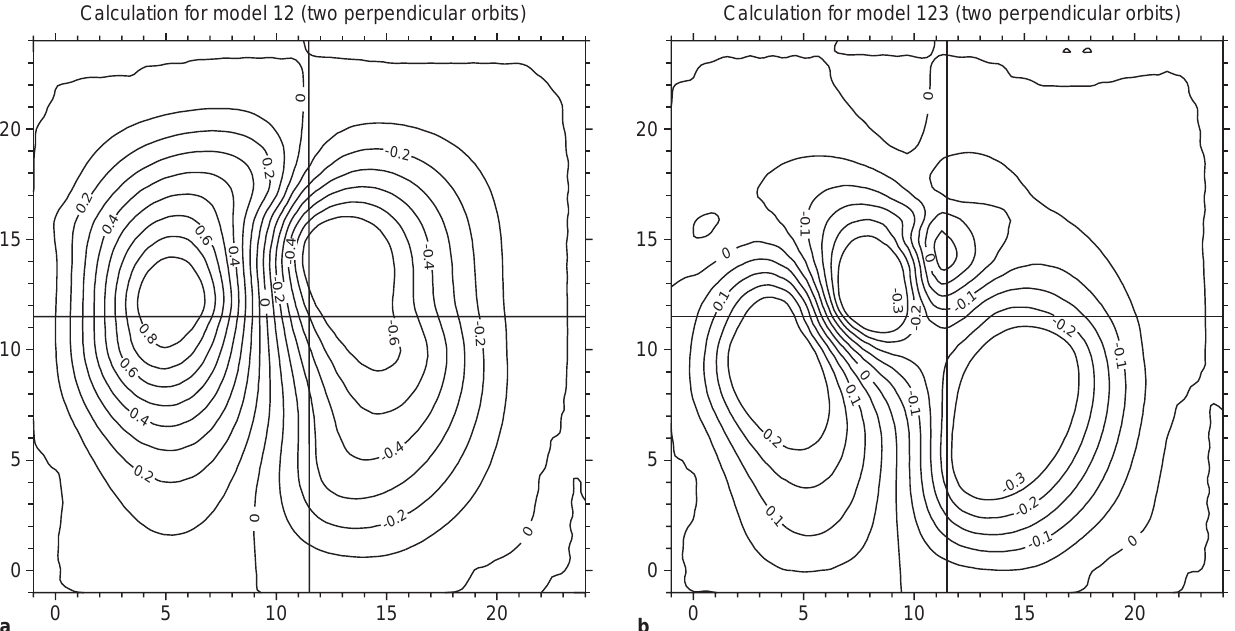
Fig. 5a, b. Convection patterns reconstructed by using the data along two perpendicular lines (one orbit case). a 2-cell convection;